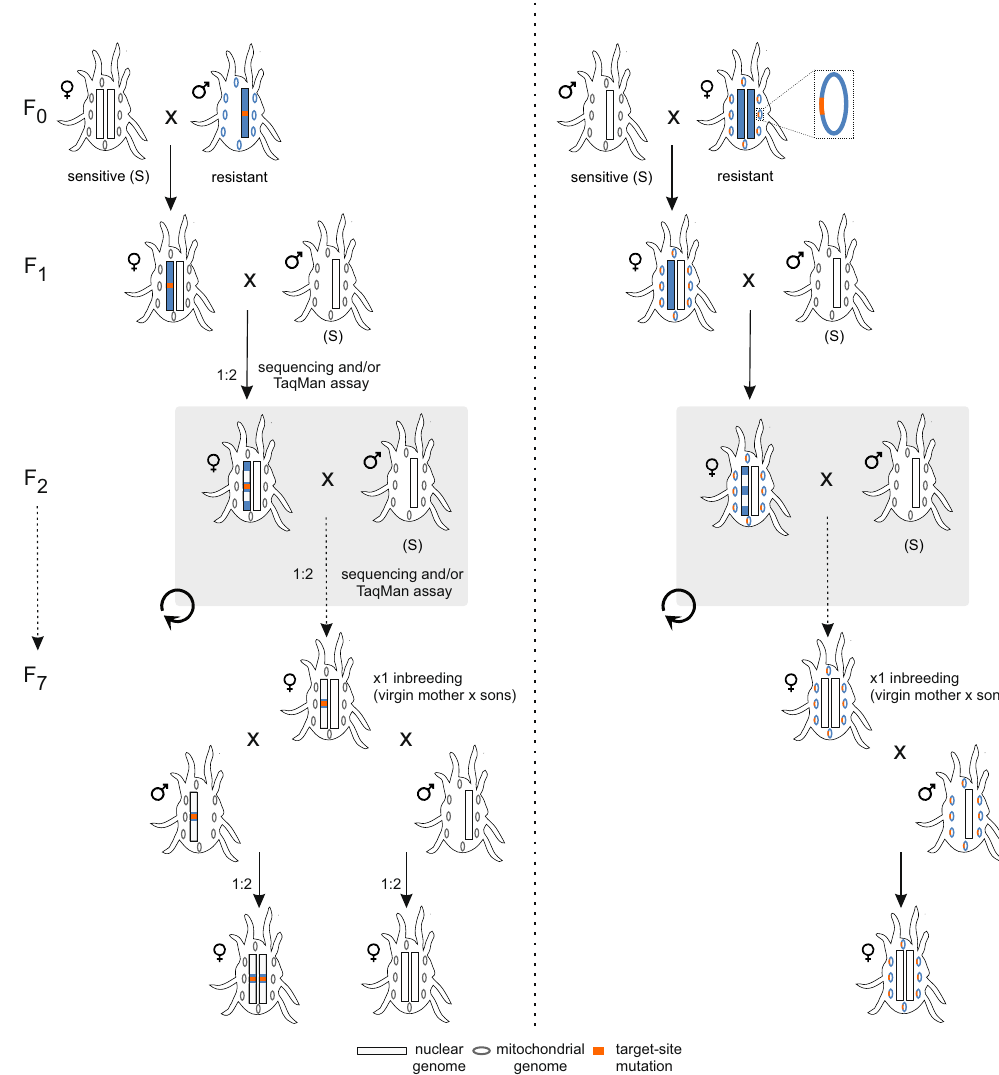
Figure 1. Schematic diagram of marker-assisted backcrossing of nuclear and mitochondrial encoded resistance mutations. The susceptible genotype is depicted by white-colored chromosomes (rectangles) and mitochondria (ovals), while those of the resistant genotype are depicted in blue. An orange color indicates whether the resistance mutation is either nuclear or mitochondrial